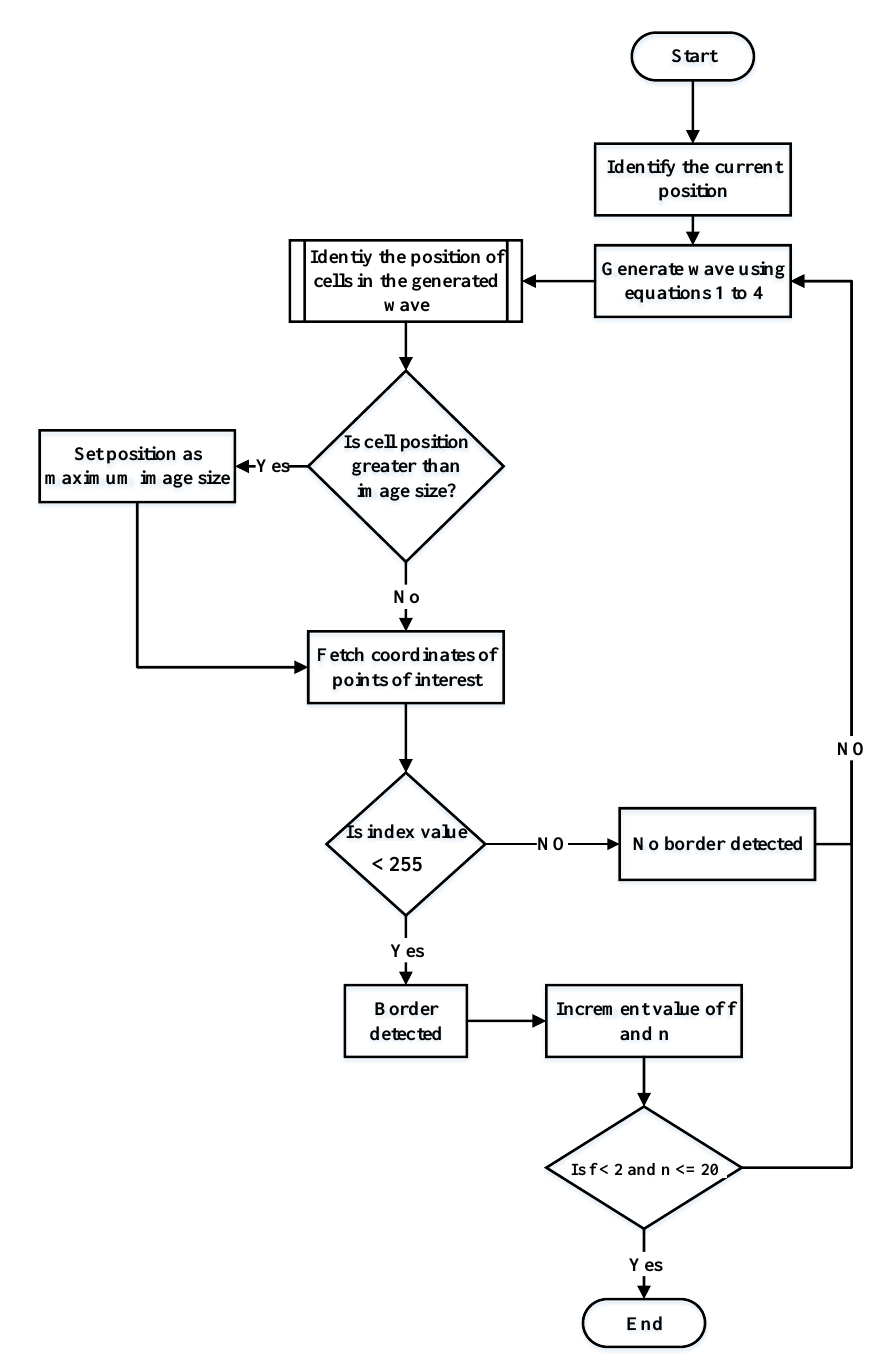
Figure 3. Flow chart of GLS working procedure.